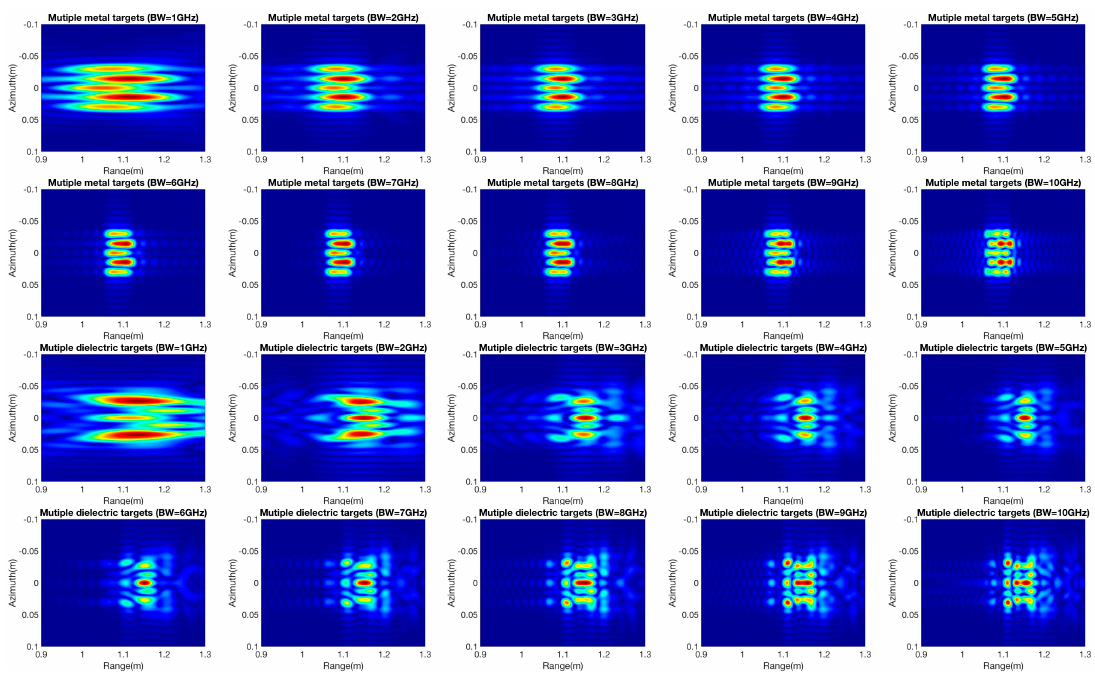
Figure 13. Images of a cluster of multiple metal spheres ( top two rows ) and dielectric spheres ( bottom two rows ) with SAR bandwidth varying from 1 GHz to 10 GHz.